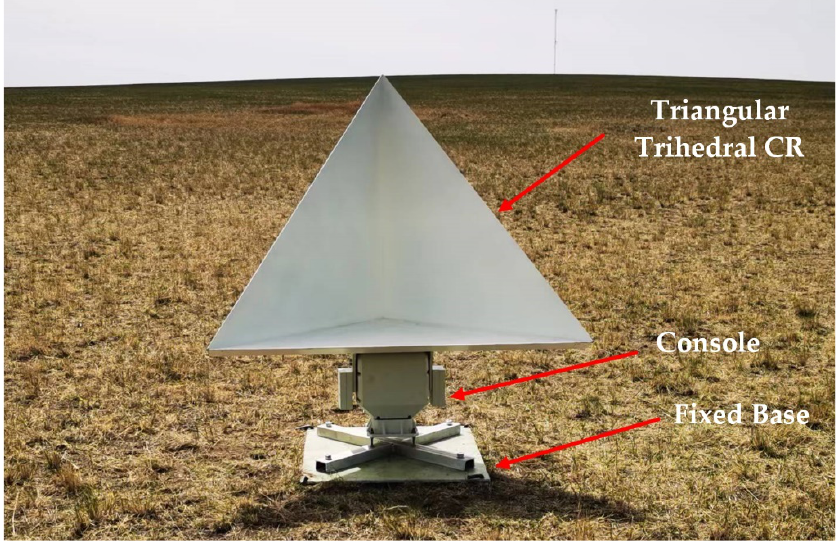
Figure 2. Flexible automatic trihedral corner reflector.